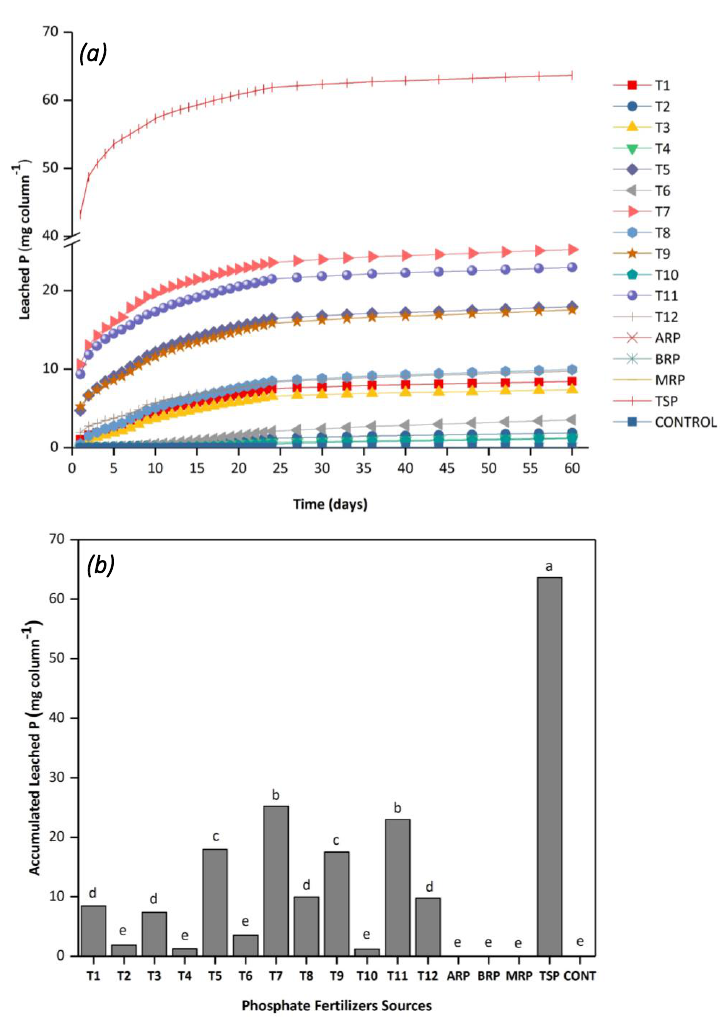
Figure 5. Phosphorus leaching from phosphate fertilizers over time ( a ) and accumulated leached P after 60 days of incubation ( b ). Mean values followed by the same letter do not differ by t -test (Scott–Knott, P < 0.05). T1 = ARP + PILC + 50% Ac.; T2 = ARP + PILC + 25% Ac; T3 = ARP + Zeo + 50% Ac; T4 = ARP + Zeo + 25% Ac.; T5 = BRP + PILC + 50% Ac.; T6 = BRP + PILC + 25% Ac.; T7 = BRP + Zeo + 50% Ac; T8 = BRP + Zeo + 25% Ac; T9 = MRP + PILC + 50% Ac.; T10 = MRP + PILC + 25% Ac.; T11 = MRP + Zeo + 50% Ac.; T12 = MRP + Zeo + 25% Ac.; ARP = Arax á rock phosphate; BRP = Bayovar rock phosphate; MRP = Morocco rock phosphate; TSP = triple superphosphate; CONT = control. PILC = pillared clay; Zeo =